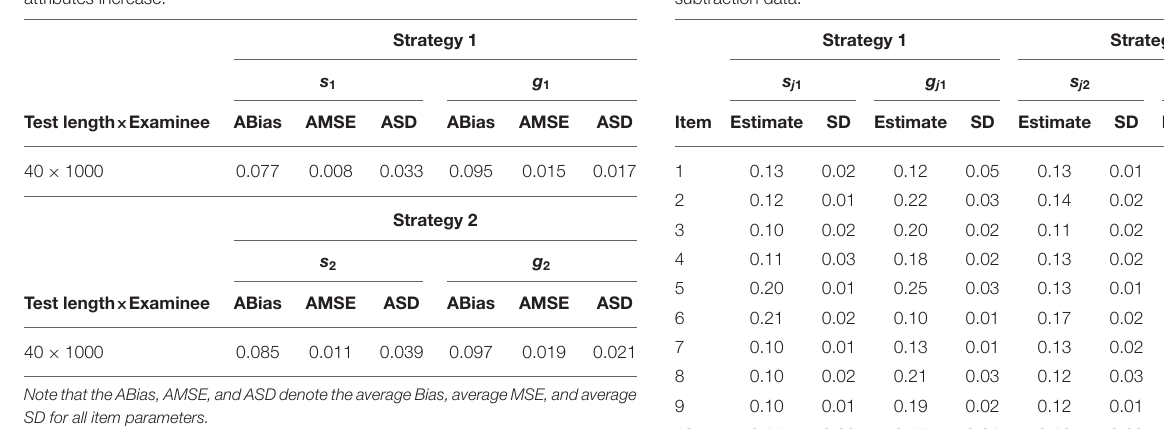
TABLE 5 | Evaluating the accuracy of the item parameters when the examined attributes increase.